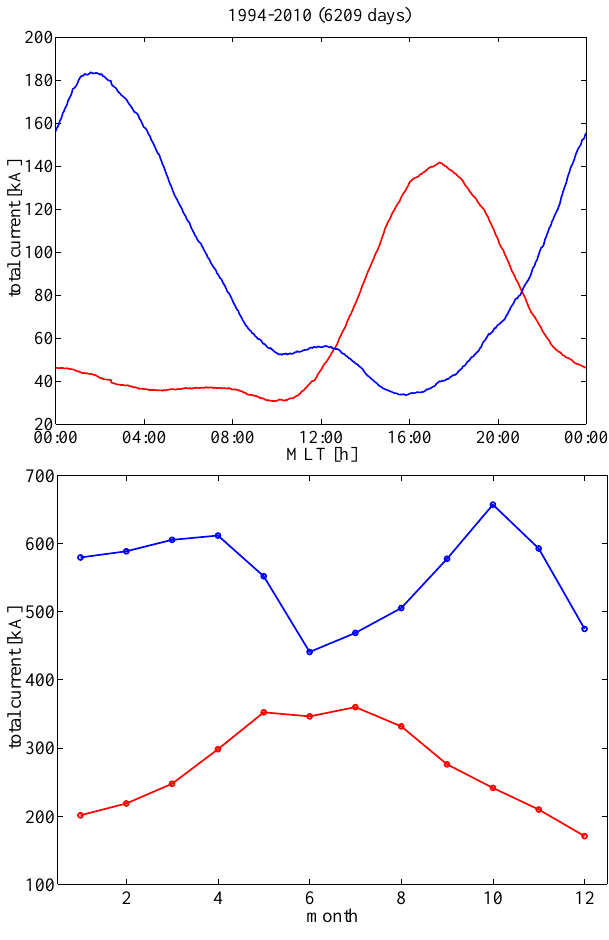
Fig. 7. Characteristics of ionospheric equivalent currents in 1994– 2010 across the geographic meridian 22.1 ◦ E in the geographic lati- tude range of 59.0–79.4 ◦ N. Upper panel: Average diurnal variation of the total eastward (red) and westward (blue) currents. Lower panel: Monthly averages of the daily maximum